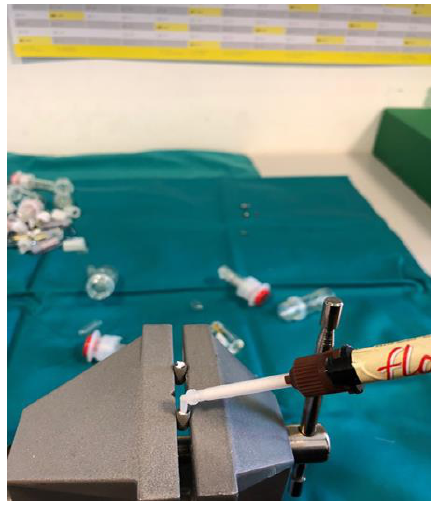
Figure 4. Oxysafe gel application.